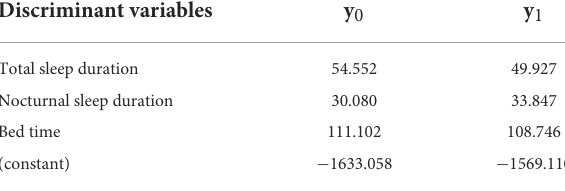
TABLE 11 Fisher function coefficients of 72–83 months age